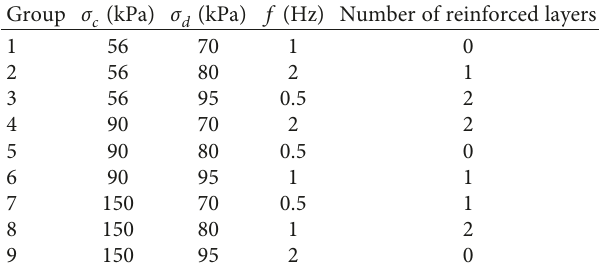
Table 4: The orthogonal